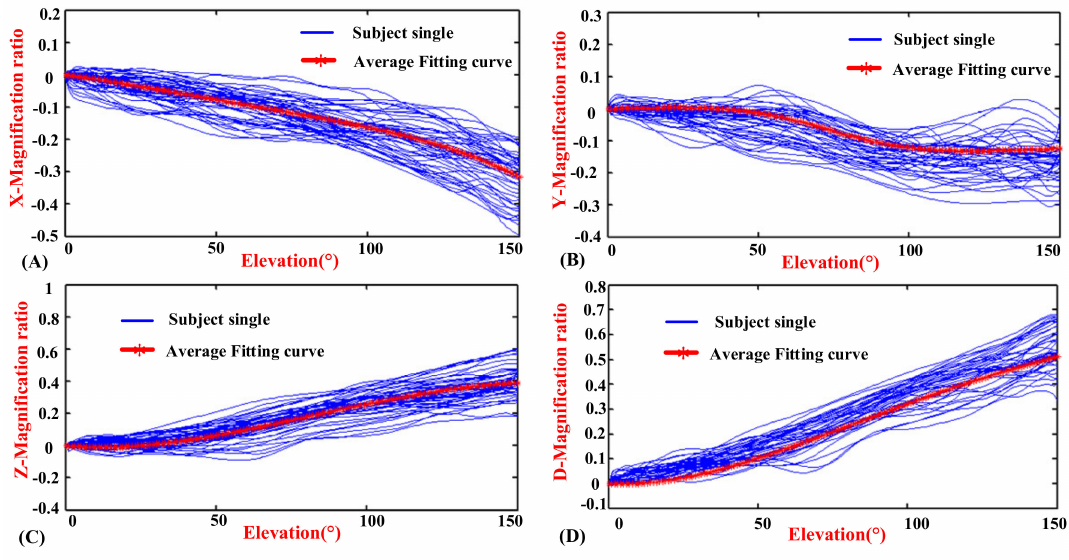
Figure 10. Diagrams of the magnification ratio of the GH joint center relative to the thorax coordinate system during humeral elevation. ( A ) X -Magnification ratio and elevation angle. ( B ) Y -Magnification ratio and elevation angle. ( C ) Z -Magnification ratio and elevation angle. ( D ) D-Magnification ratio and elevation